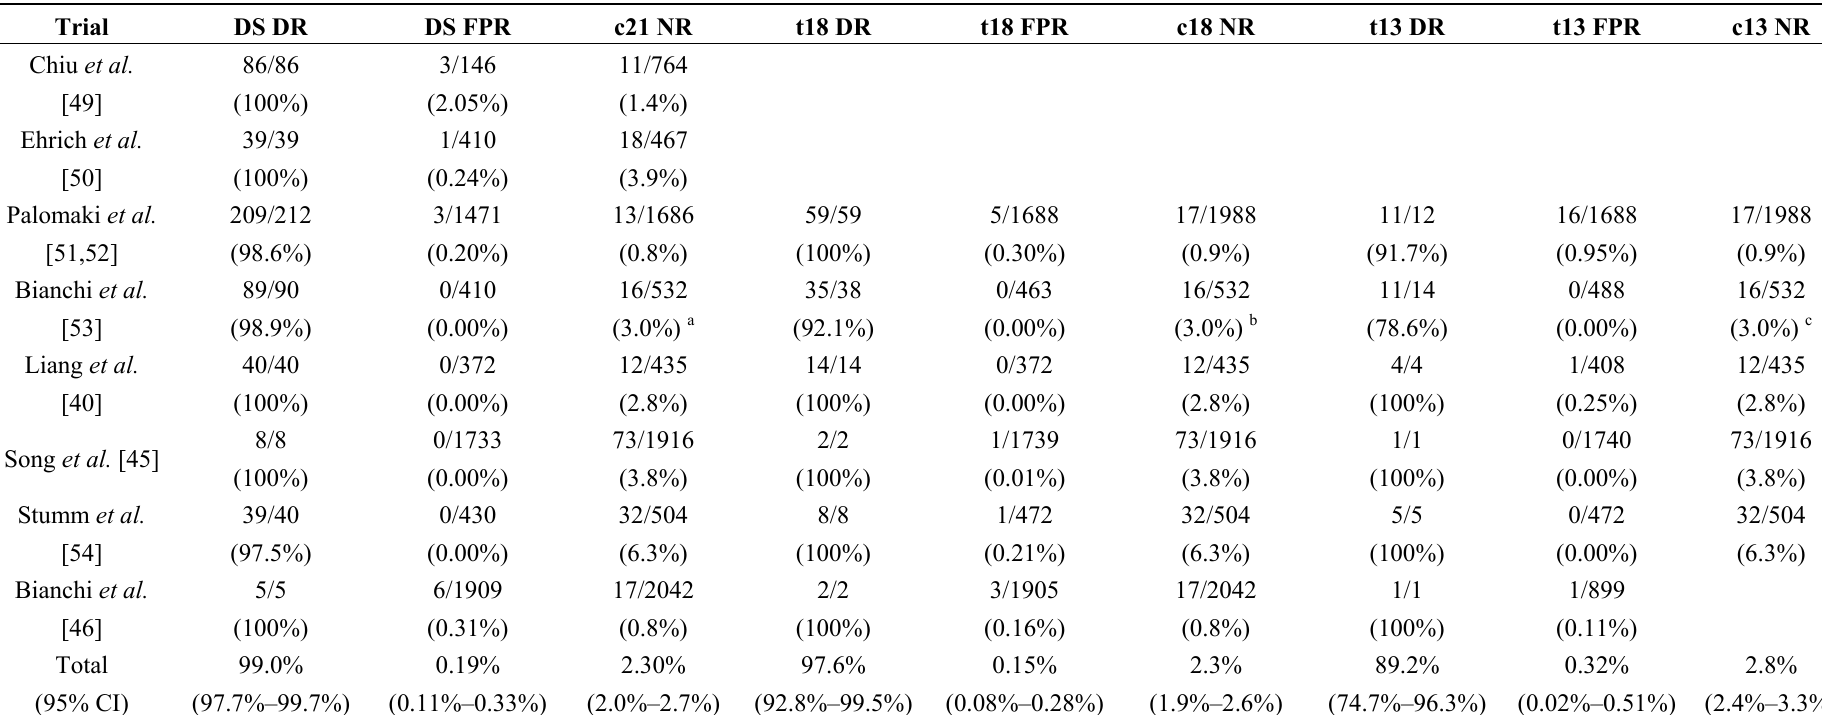
Table 1. Summary data for NIPT or non-mosaic autosomal aneuploidy using shotgun massively parallel sequencing